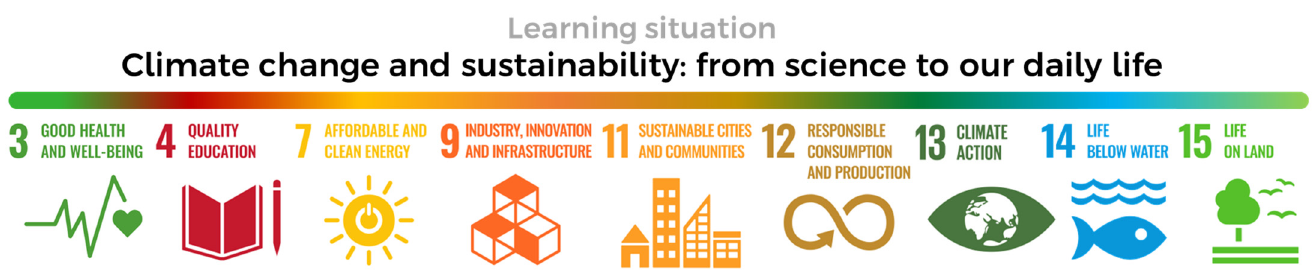
Figure 2. SDGs associated with the learning situation. Own preparation